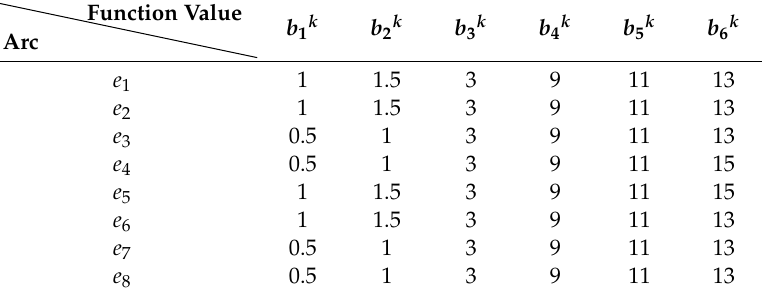
Table 17. Fuzzy function values of flow and time for each arc.